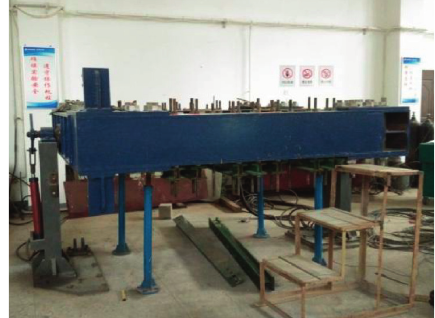
Figure 3: Horizontal loading